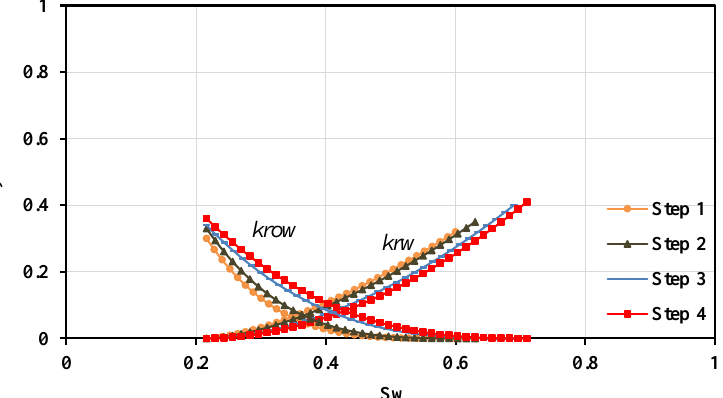
Figure 4. Relative permeability curves were used for LSWF simulation modeling with different salinities; step 1 is the formation water injection with a salinity of 3%, steps 2, 3, and 4 are with salinities of 1%, 0.5%, and 0.1%, respectively.